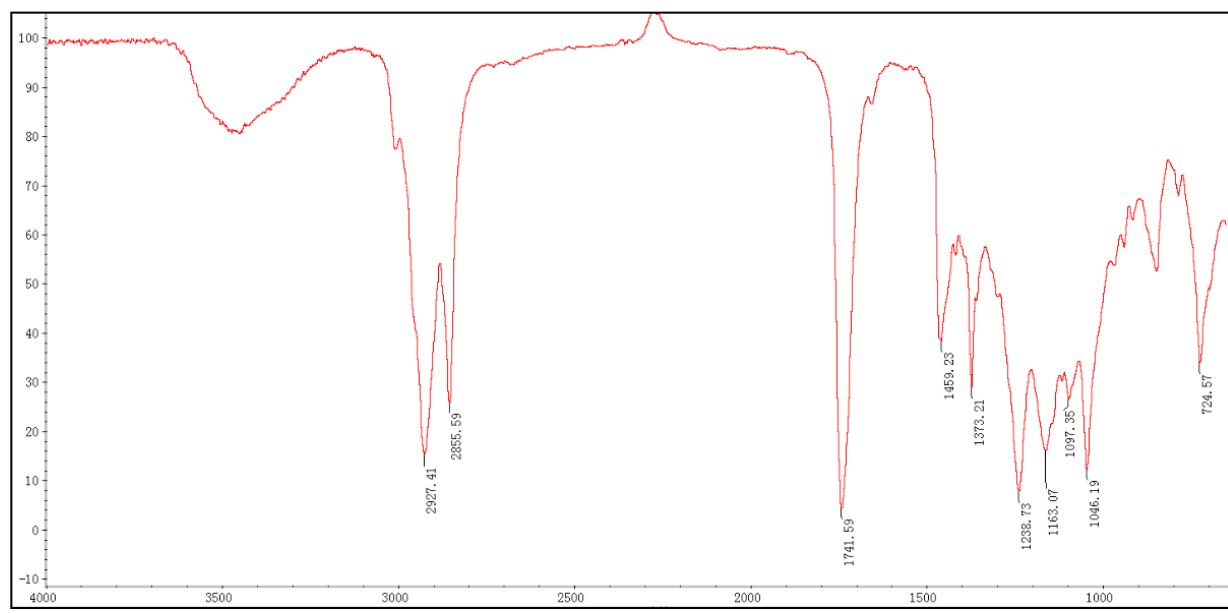
Figure 4. The infrared spectroscopy of the polyol liquid.